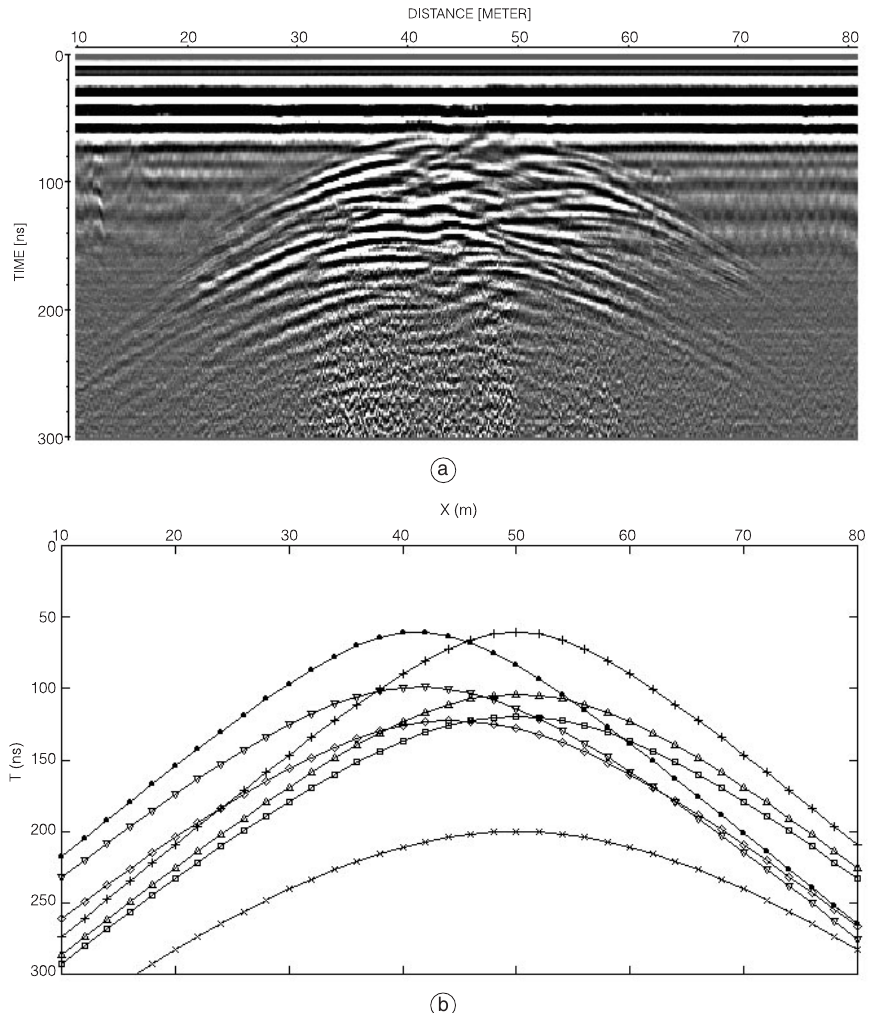
Fig. 2a,b. Example 1: Nociglia, Lecce, Italy – Surface-scattering from trees. a) Radar section relative to profile 13 (fig. 1); b) the corresponding kinematic